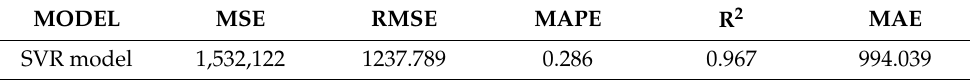
Table 5. Validation Metrics of the SVR model for the epidemic data of